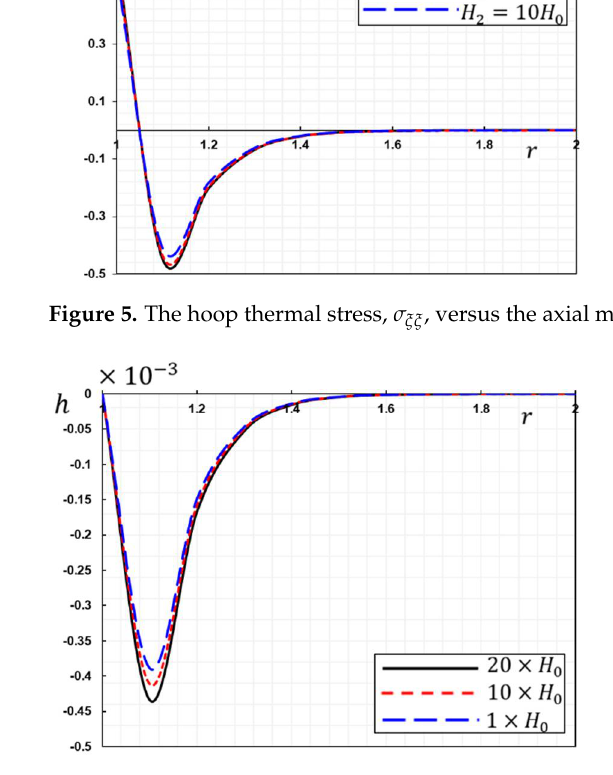
Figure 6. The induced magnetic field, h , versus the axial magnetic field, H 0 .